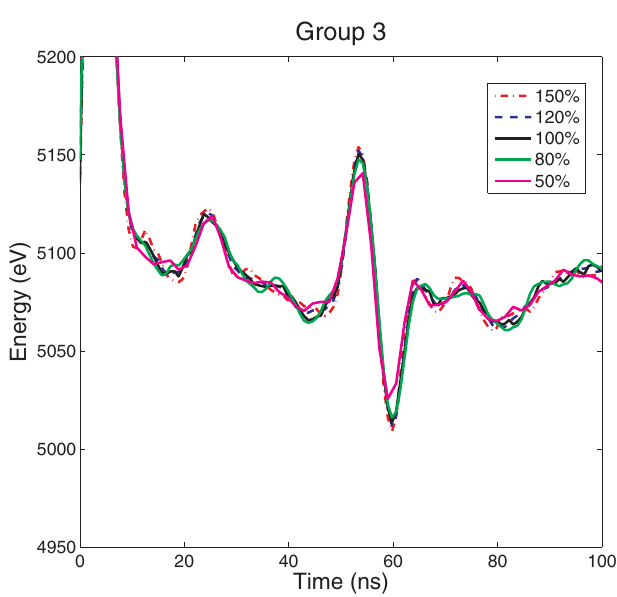
TABLE III. Energy perturbation peak-to-peak strengths and (cid:2) . (cid:2)